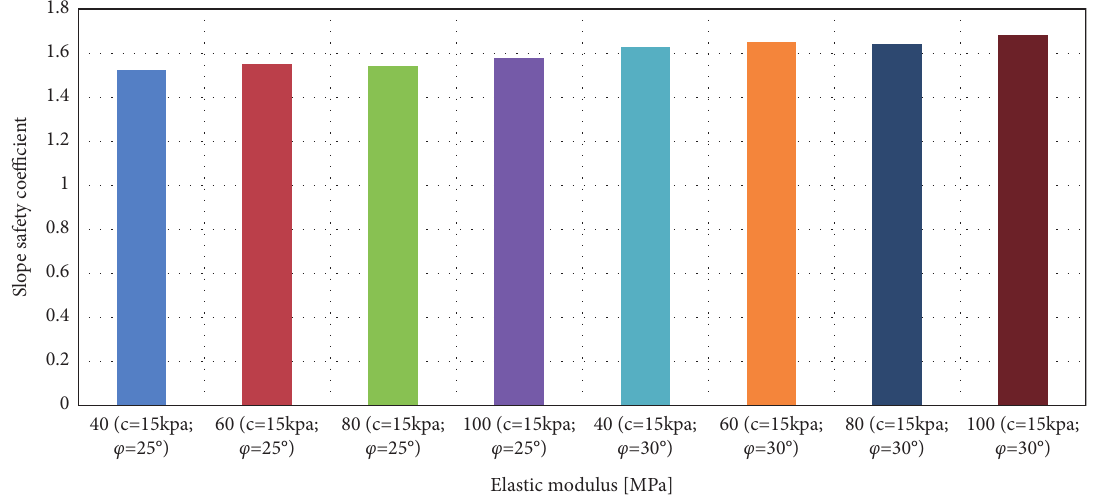
Figure 7: Safety coefficients of the road slope for varying cohesion and internal friction angle.